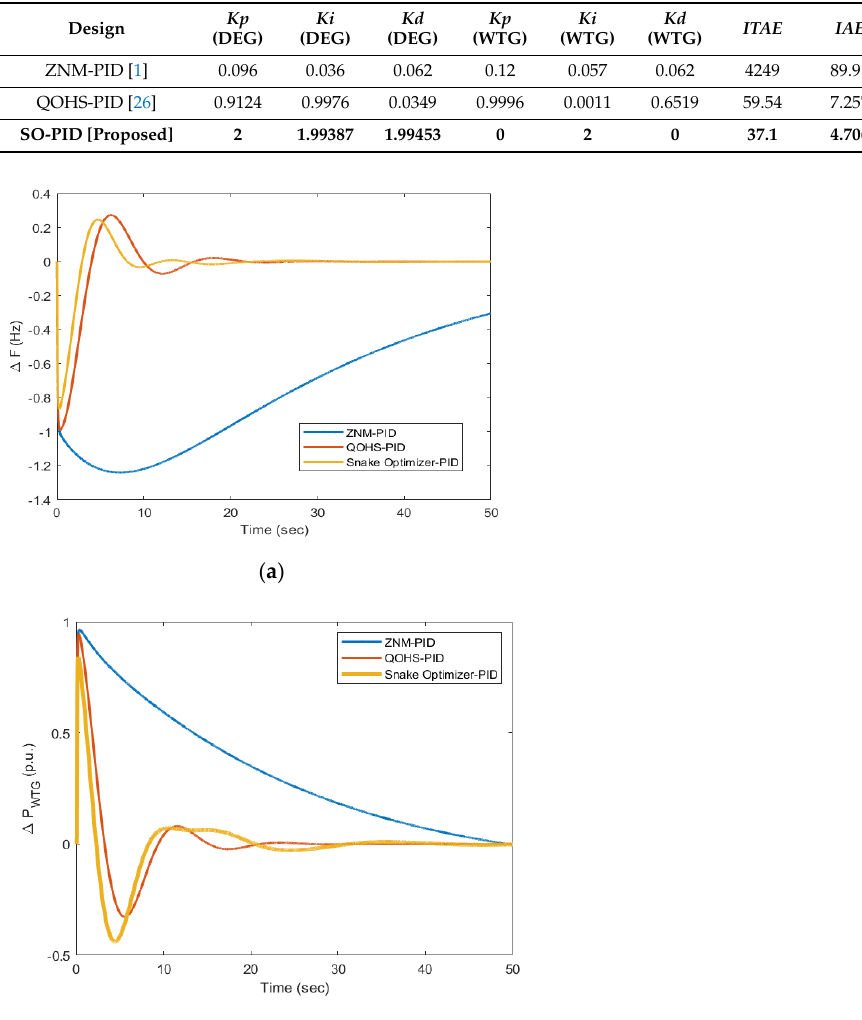
Table 2. Comparison of optimized controller gains.